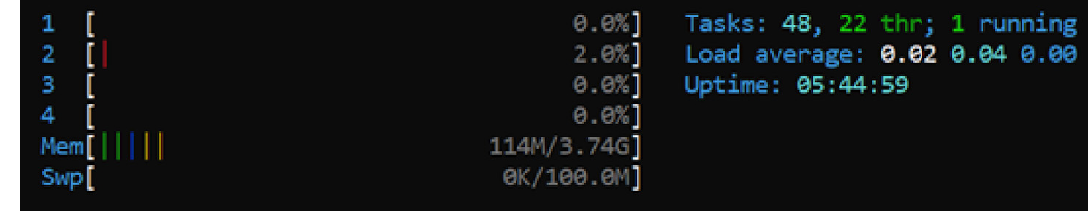
Figure 29. Using htop command to monitor RAM and CPU usage on a single core.